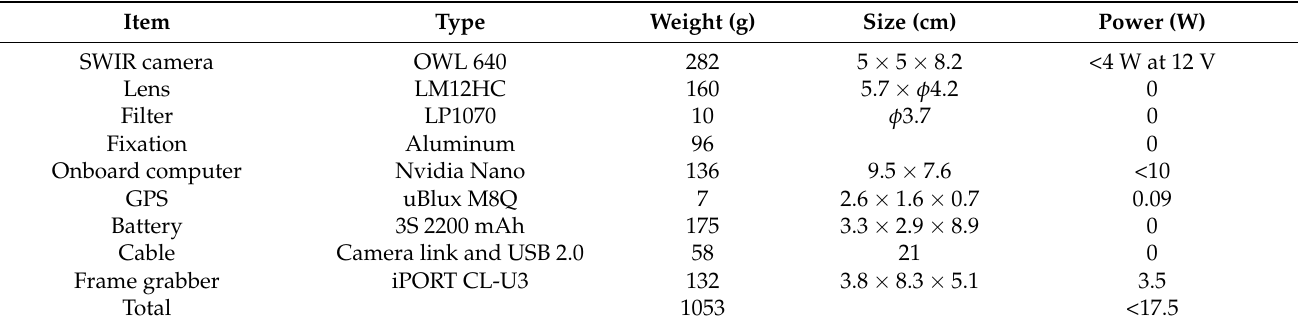
Table 1. Payload weight and power budget.